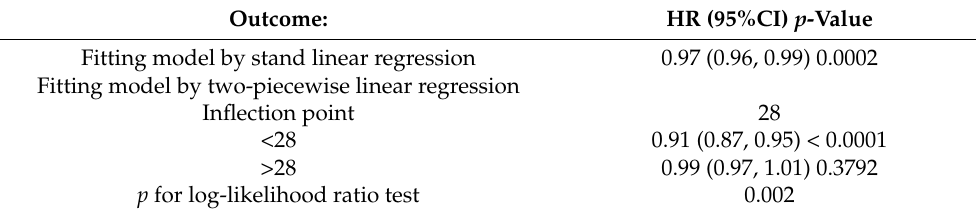
Table 3. Nonlinearity of HCT and mortality (N = 2589). Outcome: